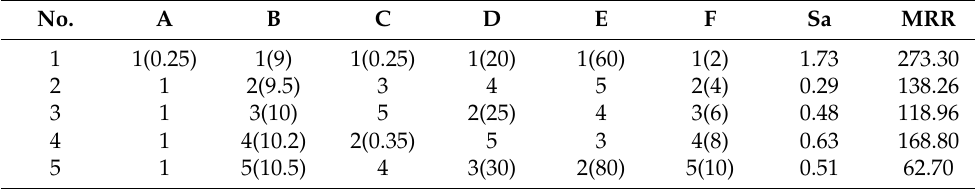
Table A1. The orthogonal experimental design and the Sa and MRR